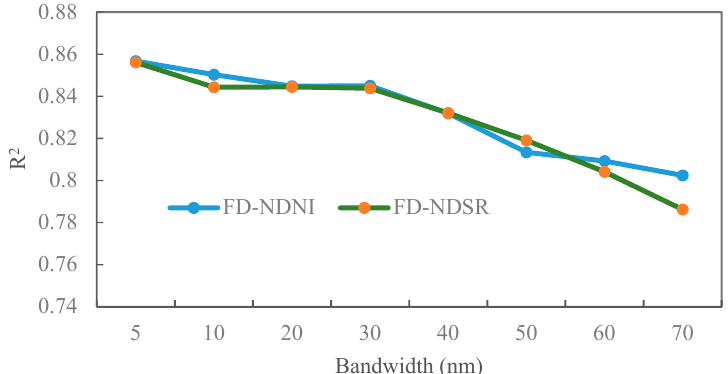
Figure 4. R 2 value between LNC and FD-NDNI/FD-SRNI constructed by different bandwidths. FD-NDNI takes 715 and 516 nm as the center wavelengths and FD-SRNI takes 715 and 526 nm as the center wavelengths.